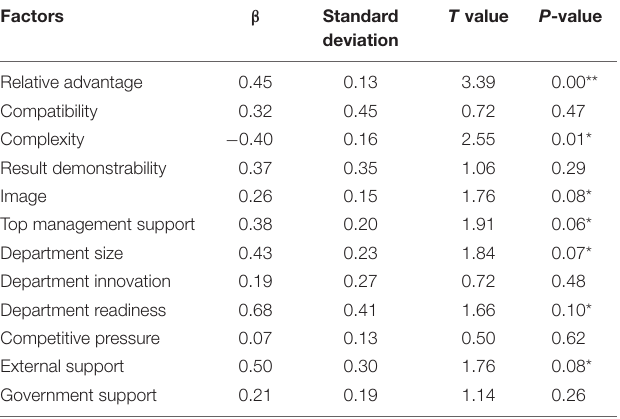
TABLE 7 | Testing results of hypotheses affecting implementation willingness.